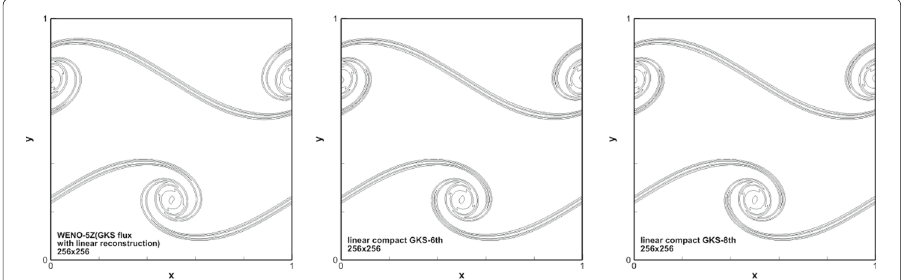
Fig.21 Double shear flow: vorticity contours at t = 0.8, obtained by non-compact linear reconstruction-based WENO-5th (GKS flux), and the linear 6th-order and 8th-order compact GKS with 256 × 256 mesh